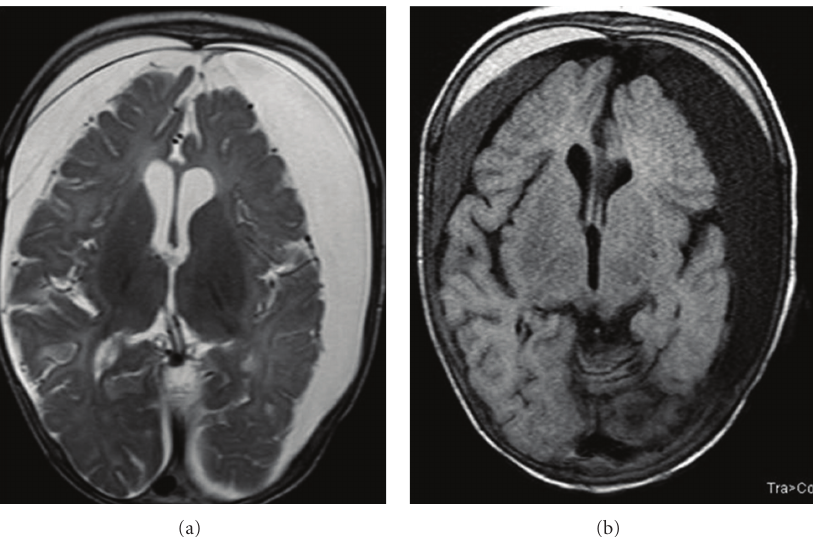
Figure 4: T2(TR: 5000, TE: 102) and fluid-attenuated inversion recovery (TR: 9000, TE: 2500) weighted axial image of brain on Siemens